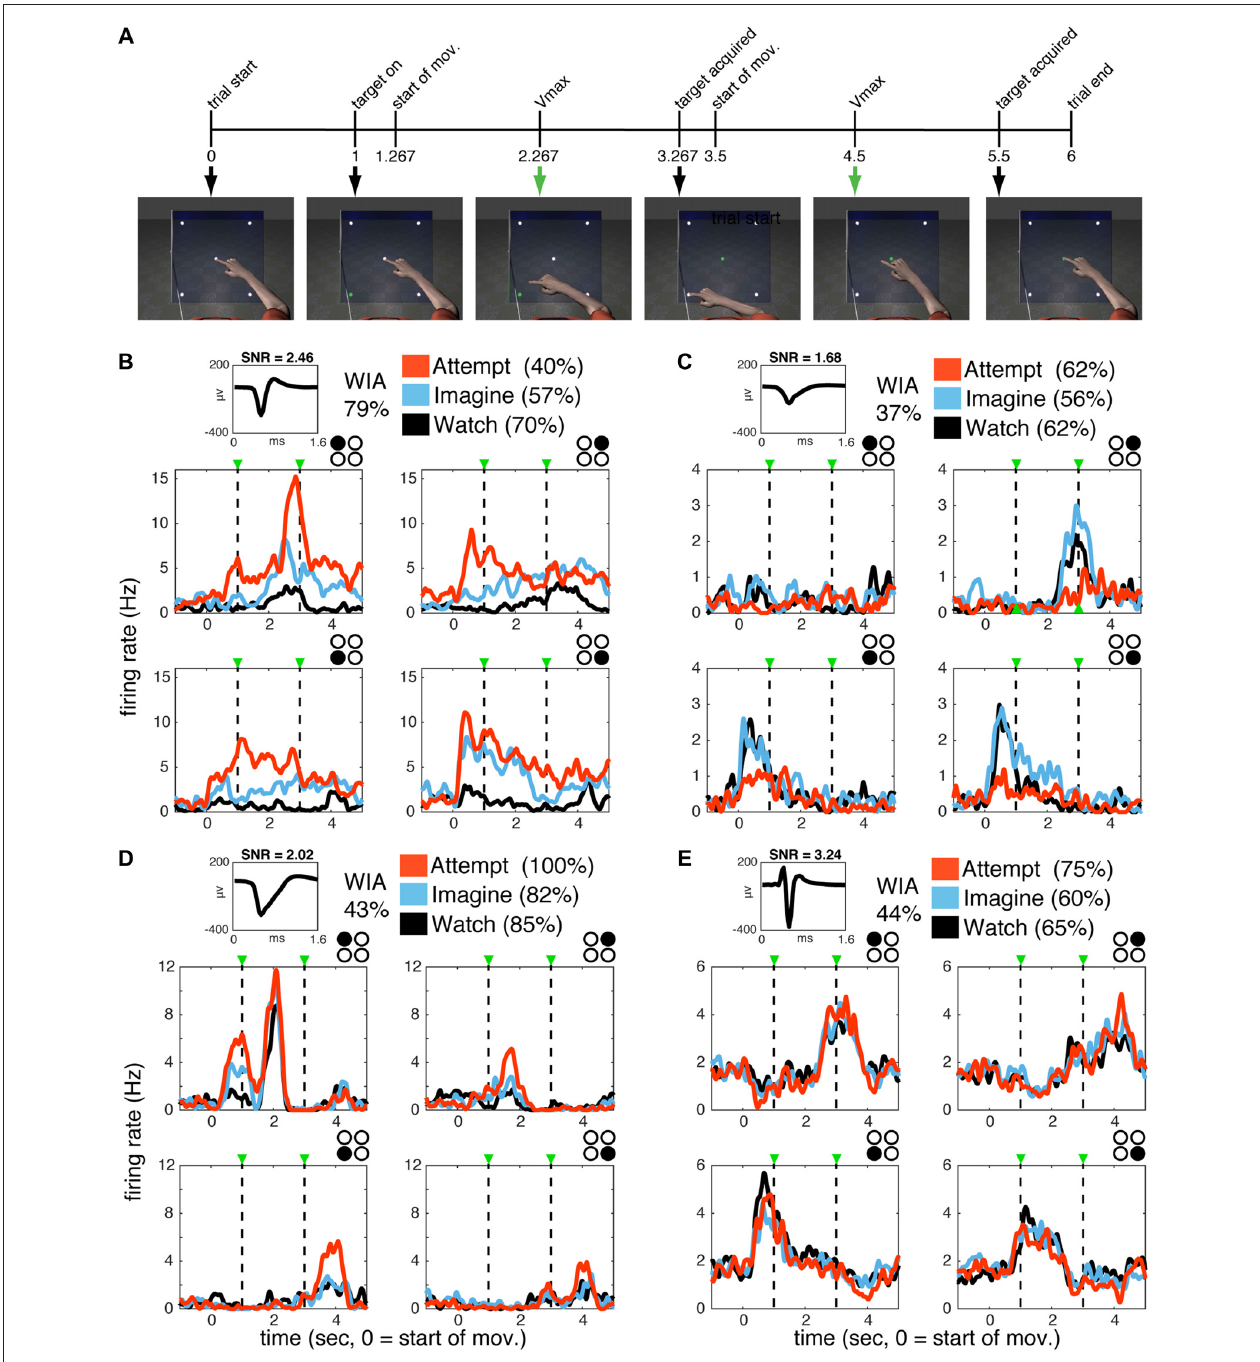
FIGURE 1 | Single units in primary motor cortex (MI) are active during watch, imagine and attempt conditions. (A) WIA task sequence. The timeline of still frames indicates the time course of animated arm movements viewed by the participants, with 0 indicating movement onset. Event timing was identical for all movement directions. The same movies were utilized in different blocks paired with verbal instructions to watch, imagine, or attempt the displayed movements given before each block. (B–E) Single-unit activity for subject S3 (B,C) and T1 (D,E) . The mean waveform for each unit is shown on the top left of each panel. Classification accuracy for each unit (% of correctly classified trials) according to volitional state (VoS) condition or action (within each VoS condition) are listed on the top left (see “Materials and Methods” section for details). Mean firing rates across W, I and A conditions (averaged over ∼ 10 trials for each target in each condition) are highlighted in black, blue and orange, respectively. Subplots are arranged spatially according to target position (indicated by filled black circle in top right corner). Plots are aligned to center-out movement onset (time zero). Dashed lines mark peak velocities for the center-out and return to center movements. Firing rates were calculated in 1 ms bins smoothed with a 250 ms Gaussian kernel for each